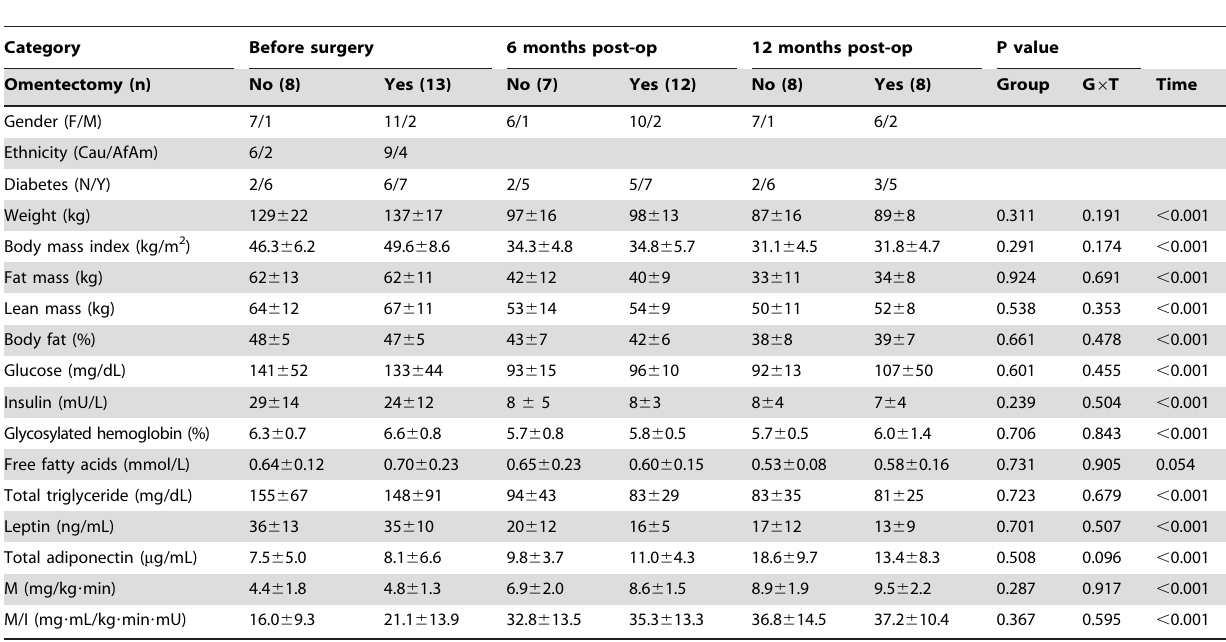
Table 1. Effect of Roux-en-Y Gastric Bypass surgery with or without omentectomy on body composition and metabolic variables.